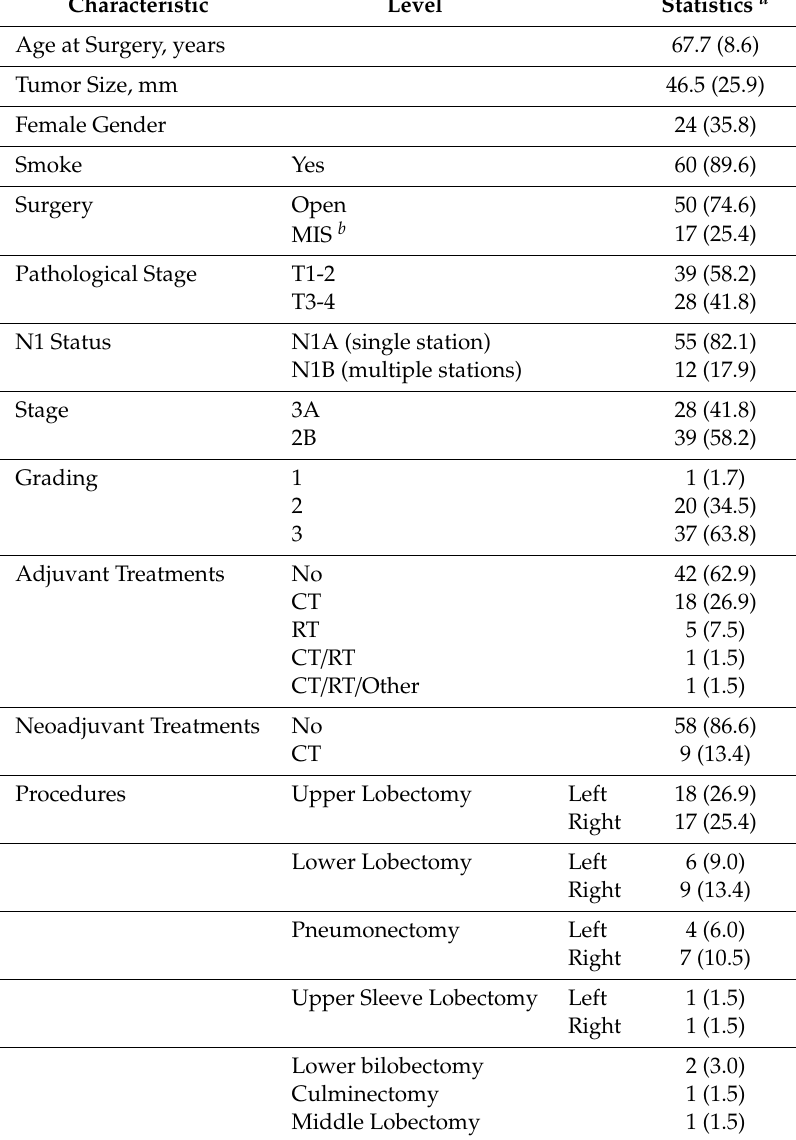
Table 2. Patients’ demographic, treatment, and procedure summary